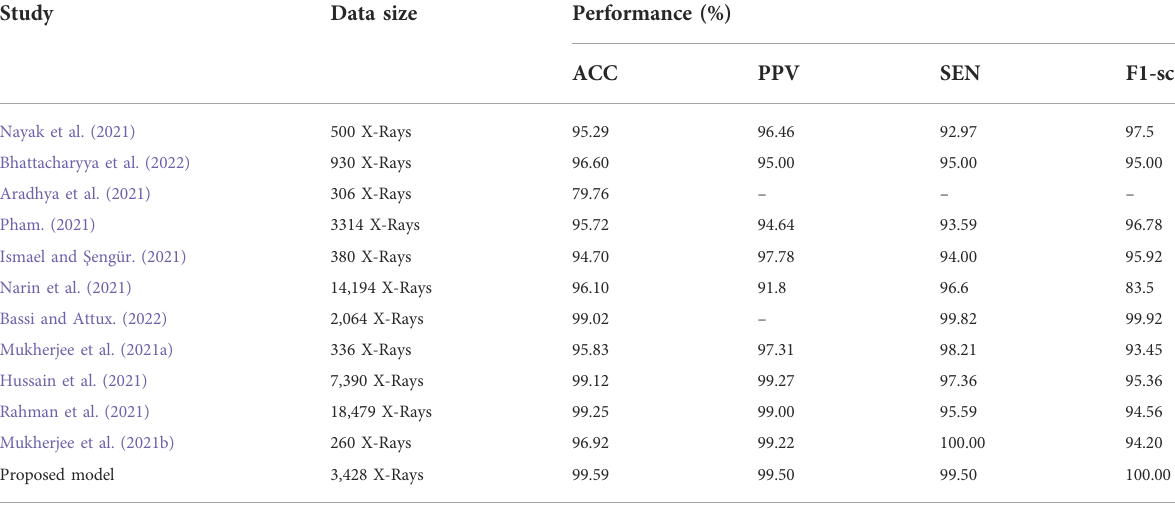
TABLE 6 Performance comparison of the stated COVID-19 identi fi cation model with others works on